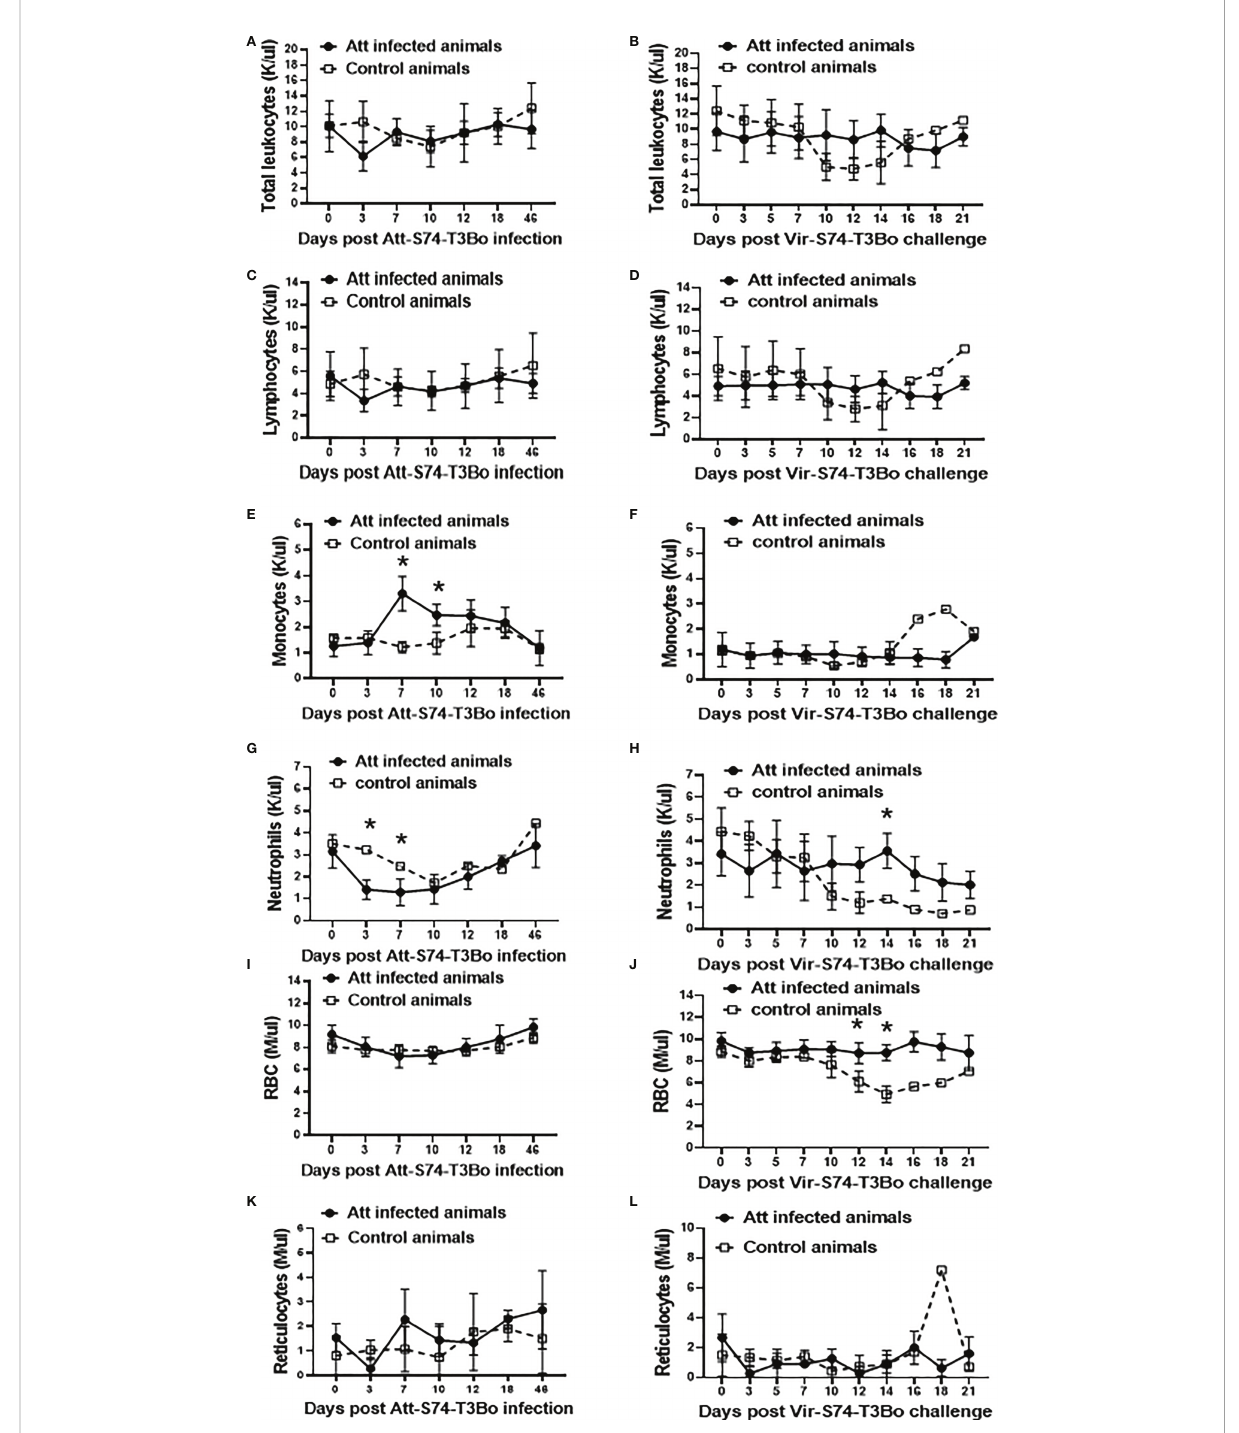
FIGURE 3 Absolute numbers of total leukocytes (A, B) , lymphocytes (C, D) , monocytes (E, F) , neutrophils (G, H) , red blood cells (RBC) (I, J) , and reticulocytes (K, L) after infections with the in vitro culture attenuated B . bovis strain Att-S74-T3Bo and the virulent B. bovis strain Vir-S74-T3Bo. Att infected animals (n=3). Control animals (n=3; two animals of the control group were humanely euthanized at days 13 and 14 after Vir-S74- T3Bo inoculation due to the severity of the disease). *